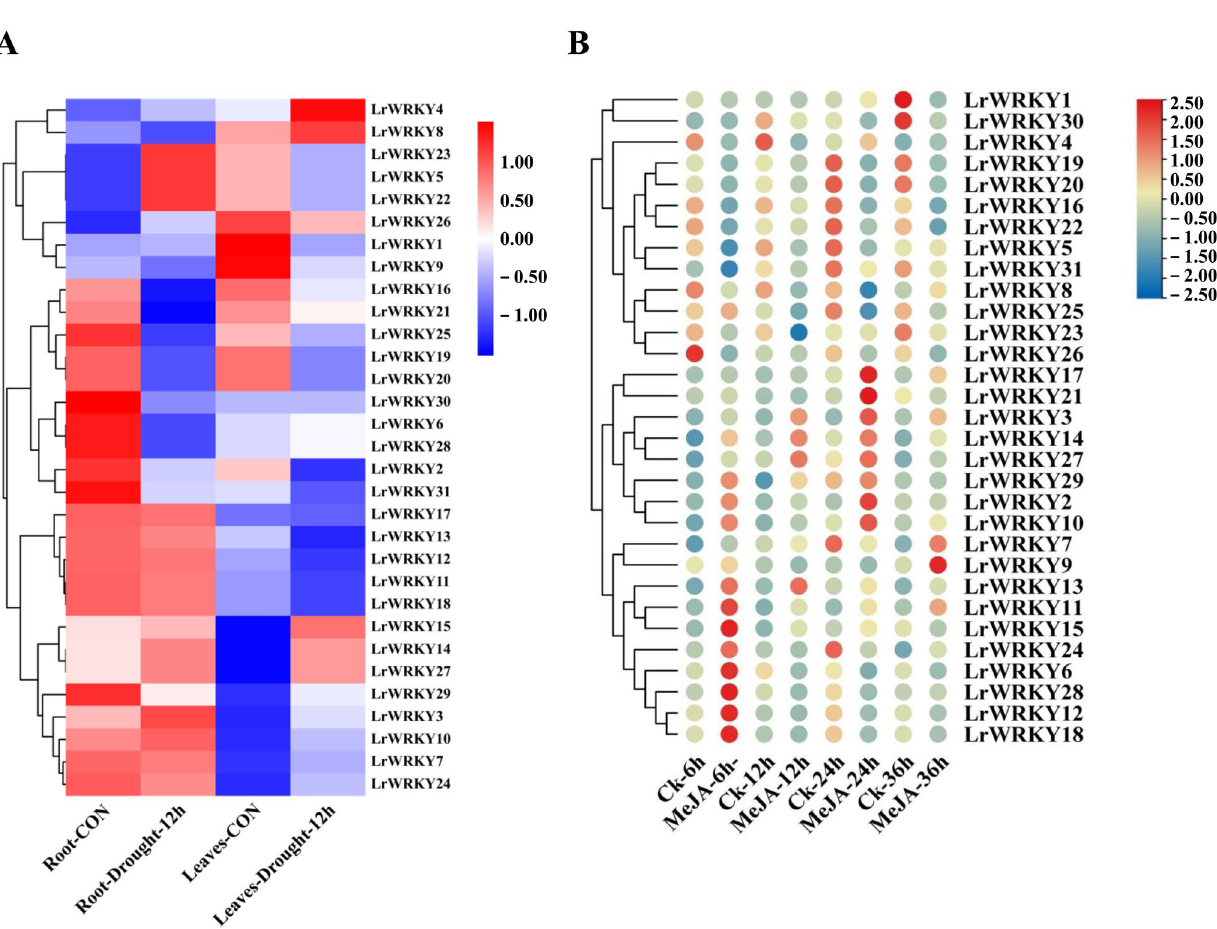
Figure 6. LrWRKY gene expression profiles under drought stress and MeJA treatment in L. radiata. ( A ) Heatmap with hierarchical cluster analysis of drought-responsive differentially expressed LrWRKY genes. ( B ) Heatmap of LrWRKY genes expression profiles with MeJA treatment. Red and blue represent high and low relative transcript abundance, respectively.